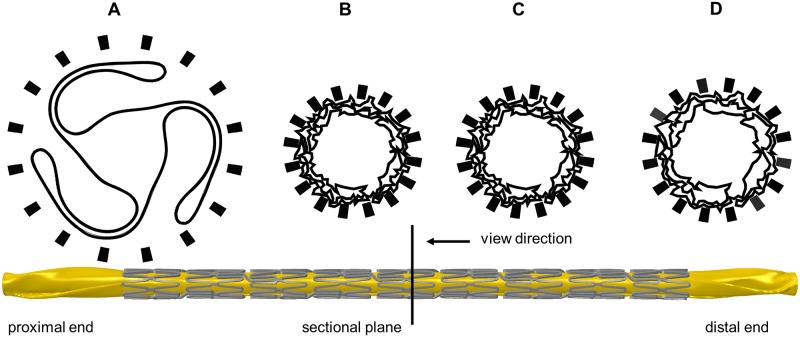
Successive simulation results of the stent crimiping process.A: Initial balloon-stent configuration before crimping. B: Maximum compressed stent configuration after rotating the crimp jaws (not visualized) around their pivot point and thereby reducing the diameter of the crimp iris. C: Holding phase. D: Final crimped stent-balloon configuration after retraction of the crimping jaws and stent recoil.